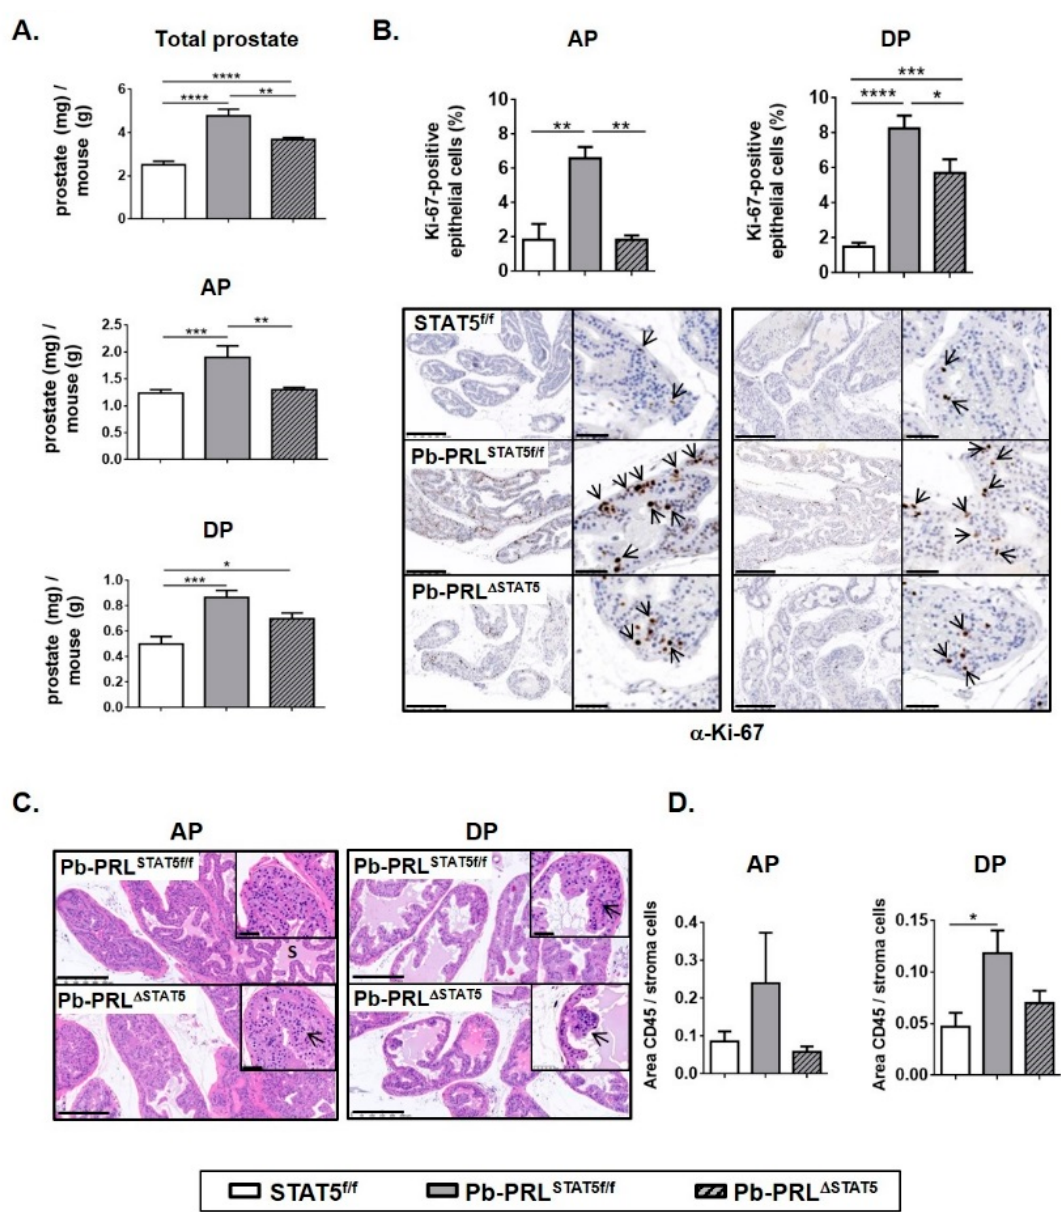
Figure 2. STAT5 deletion reduces hallmarks of early prostate tumorigenesis in 6 month-old Pb-PRL Δ STAT5 mice. A. The weight of total prostate and of anterior (AP) and dorsal (DP) prostate lobes of STAT5 f/f , Pb-PRL STAT5f/f and Pb-PRL Δ STAT5 mice is expressed as the ratio of prostate tissue weight normalized to the weight of corresponding animal (see Figure S4A for other lobes). B. Cell proliferation in anterior and dorsal lobes was assessed by immunostaining using anti-Ki-67 antibody (hematoxylin counterstaining). Arrows in insets show representative Ki-67 nuclear immunostaining in epithelial cells. The proliferation index (ratio of Ki-67-positive versus total epithelial cells) was quantified using Calopix software (see Figure S4 for other lobes). C. Histological analysis (hematoxylin counterstaining) of anterior and dorsal lobes of Pb-PRL STAT5f/f and Pb-PRL Δ STAT5 mice showing similar hyperplasia in both genotypes (see Figure S4 for other lobes). D. Inflammation was identified using CD45 immunostaining. The degree of inflammation was quantified using Calopix software and is represented as the ratio of CD45+ area versus stroma area. Statistics : Stars denote significant differences in a repeated-measures one-way ANOVA with Tukey's multiple comparisons. Size bars: 250 µm in large images and 50 µm in insets.